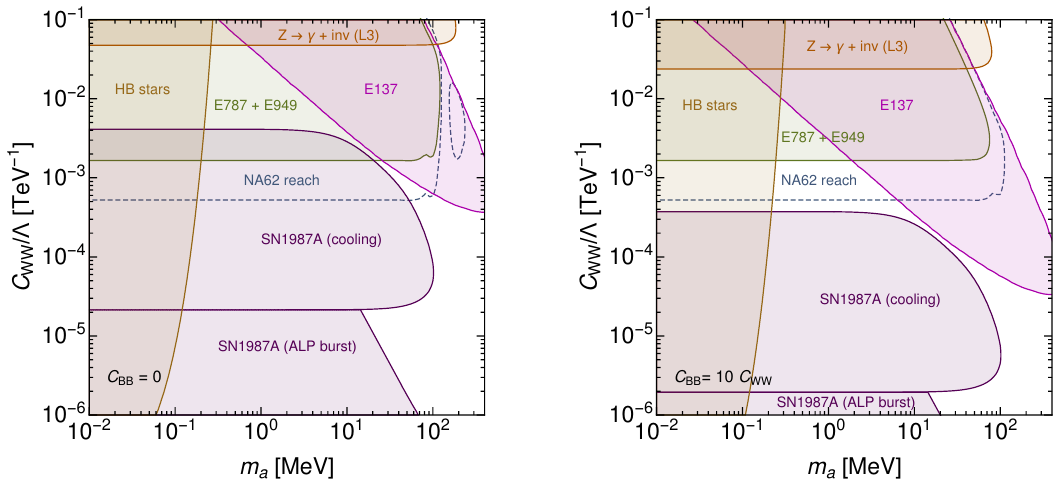
Figure 3 . Experimental constraints and prospects on ALPs interacting dominantly with elec- troweak gauge boson. On the left we focus on a sizeable value of C WW . On the right we additionally assume C BB = 10 C WW as an example of how to circumvent the supernova